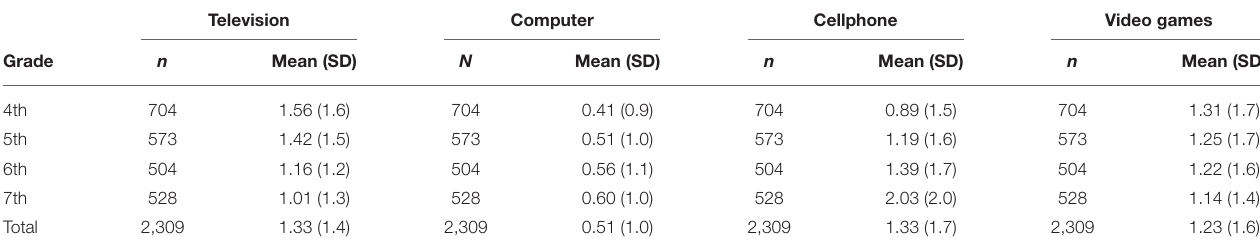
TABLE 2A | Average hours spent using technological devices every weekday by grade ( n = 2,309; Missing data = 131).